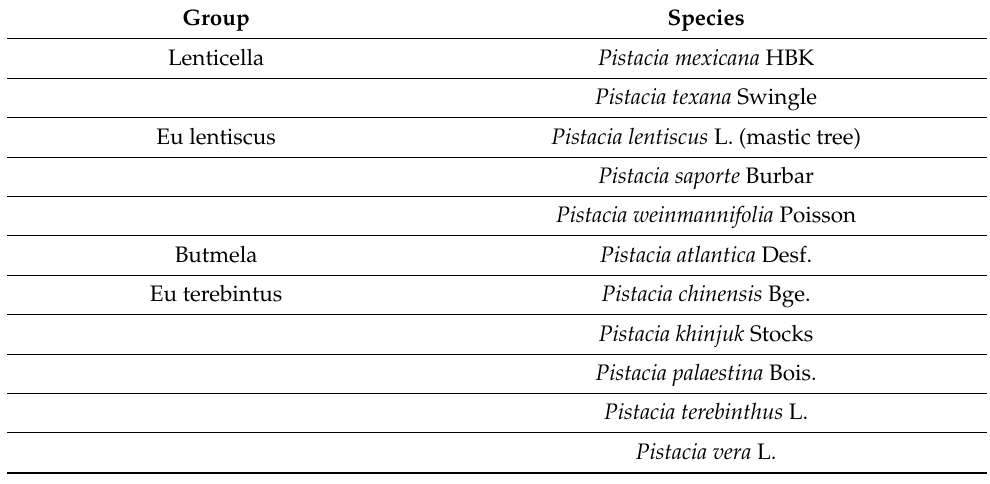
Table 1. Taxonomy description (groups and species) of the Pistacia genus (adapted from Zohary [16]).